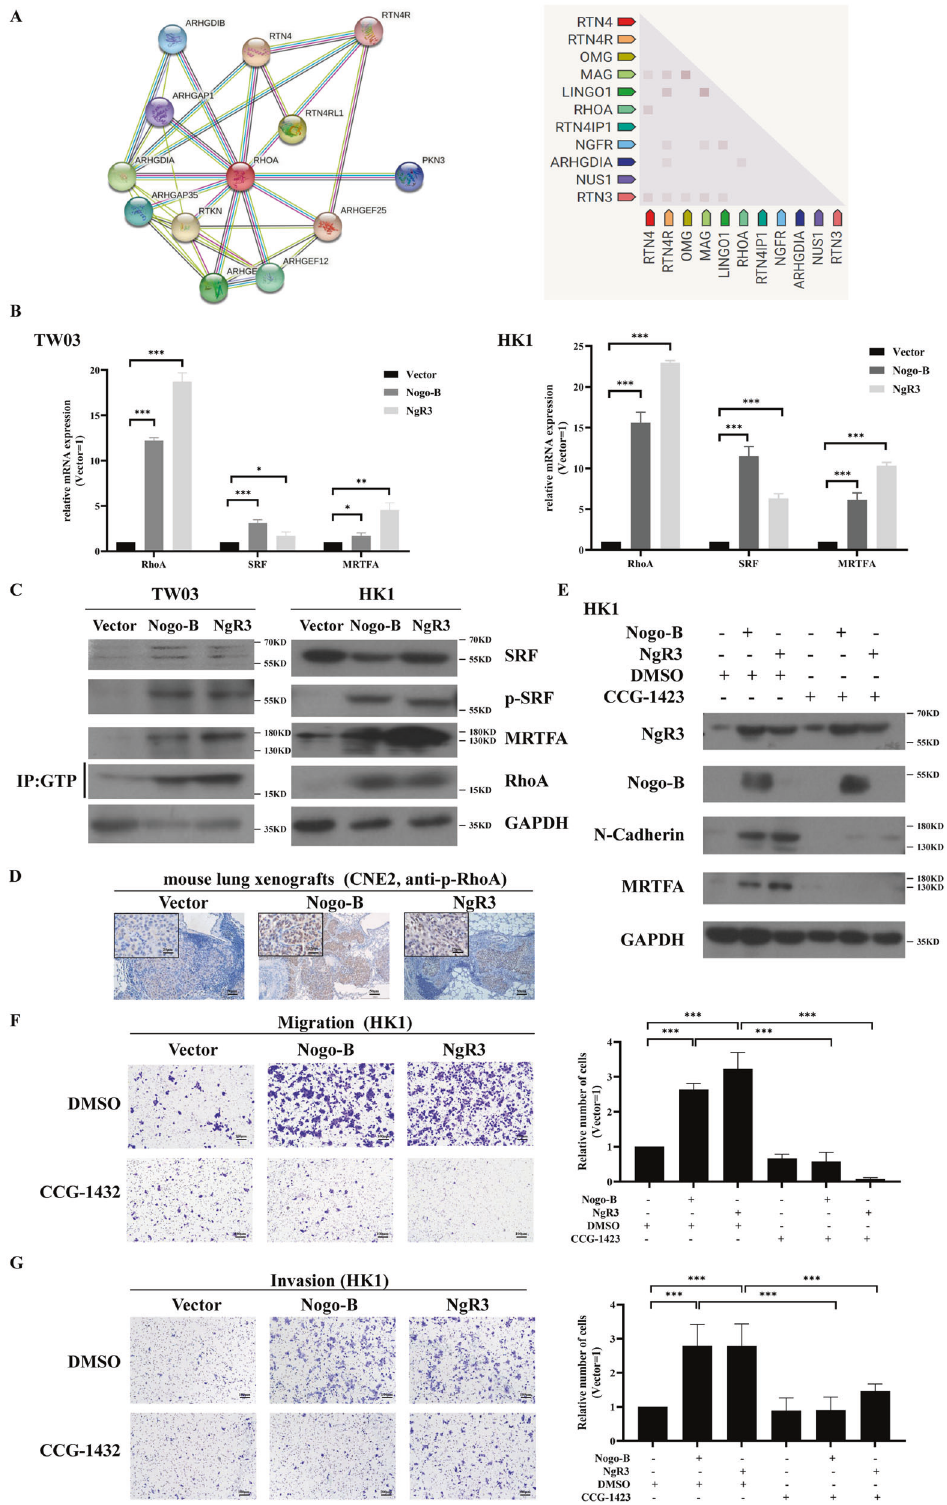
Fig. 6 Nogo-B promotes NPC cell migration by regulating RhoA-SRF-MRTFA. A The STRING database showed that Nogo-B and RhoA were associated. B Real-time PCR showed that RhoA, MRTFA, and SRF were highly expressed in TW03 (left) and HK1 (right) cell lines overexpressing Nogo-B and NgR3. C Western blotting showed that RhoA-GTP, MRTFA, and SRF were highly expressed in TW03 (left) and HK1 (right) cell lines overexpressing Nogo-B and NgR3. D Immunohistochemistry showed that overexpressing NgR3 and Nogo-B upregulated p-RhoA expression in metastatic mouse lung xenografts. E After treatment with CCG-1423(30 μ mol/L) for 24h, the expression of FAK and N-Cadherin decreased in HK1 cell lines. F The average number of migrated cells in three fi elds of HK1 cell lines with overexpressing Nogo-B or NgR3 decreased after using CCG-1423(30 μ mol/L). G The average number of invaded cells in three fi elds of HK1 cell lines with overexpressing Nogo-B or NgR3 decreased after using CCG-1423(30 μ mol/L).